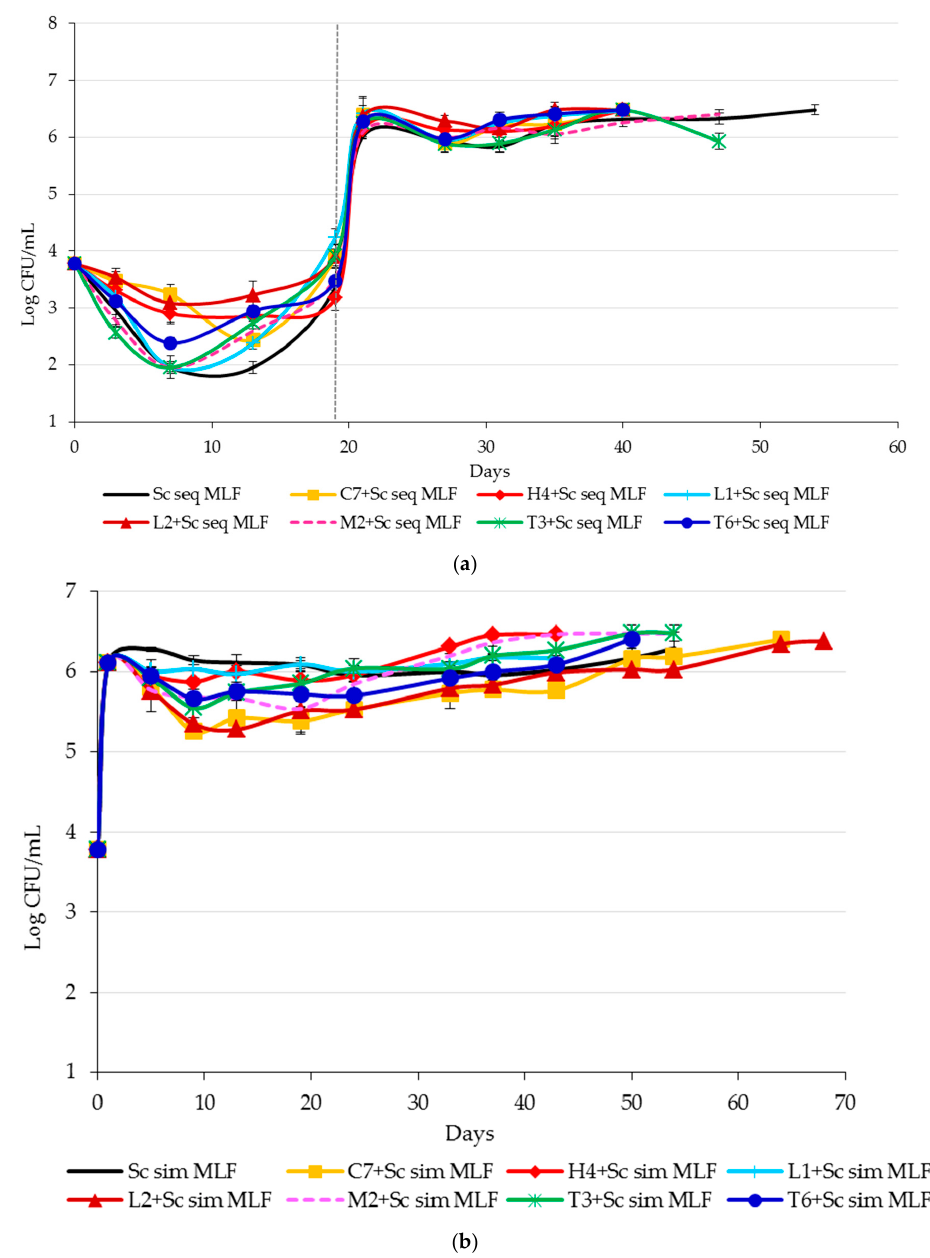
Figure 2. Cell counts (colony forming units per millilitres) of the naturally occurring lactic acid bacteria and inoculated Oenococcus oeni in Shiraz wines produced with Saccharomyces cerevisiae (Sc) on its own or in combination with Candida zemplinina C7, Hanseniaspora uvarum H4, Lachancea thermotolerans strains L1 and L2, Metschnikowia pulcherrima M2 and Torulaspora delbrueckii strains T3 and T6, as well as three malolactic fermentation (MLF) strategies (none, simultaneous and sequential). ( a ) Wines that underwent sequential malolactic fermentation (seq MLF) and the dashed vertical line at day 19 indicates when the commercial O. oeni was inoculated. ( b ) Wines where the commercial O. oeni was inoculated after 24 h (day 1) to induce MLF as a simultaneous inoculation (sim MLF). Values are averages of three replicates and the error bars indicate the standard deviation.